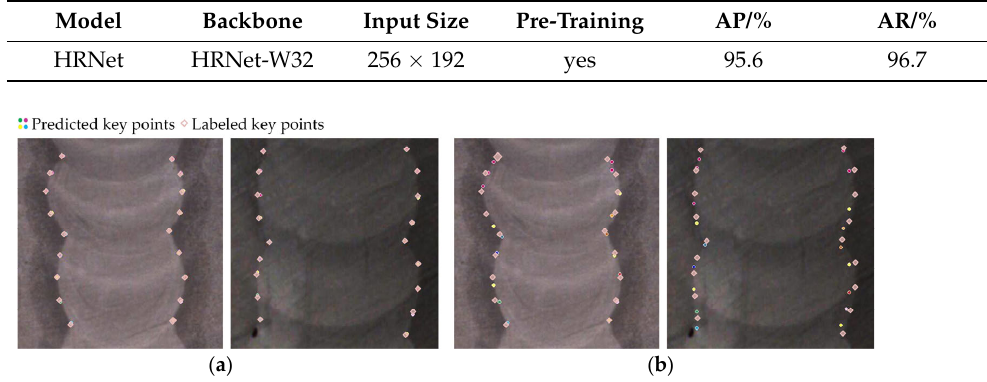
Table 4. HRnet network key point detection results.